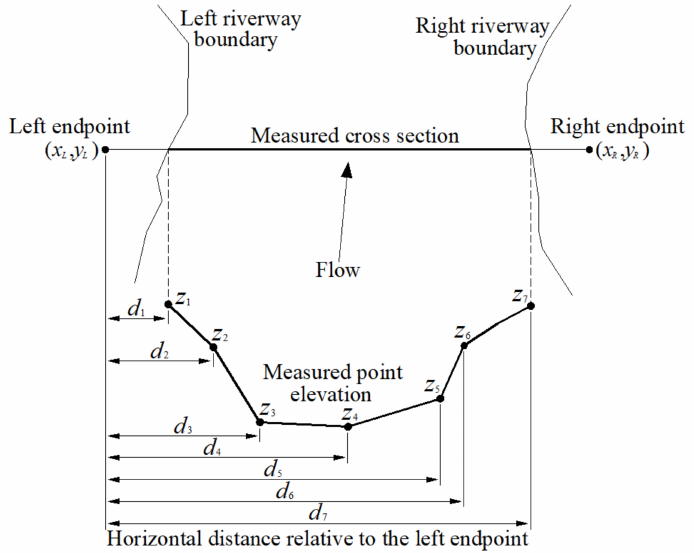
Figure 2. Distributions of longitudinal control lines and measured cross sections (The exemplified riverway is located between the Three Gorges Dam and Gezhouba Dam in China and approximately 30 km in length. The distances between the adjacent sections are approximately 600~1100 m).